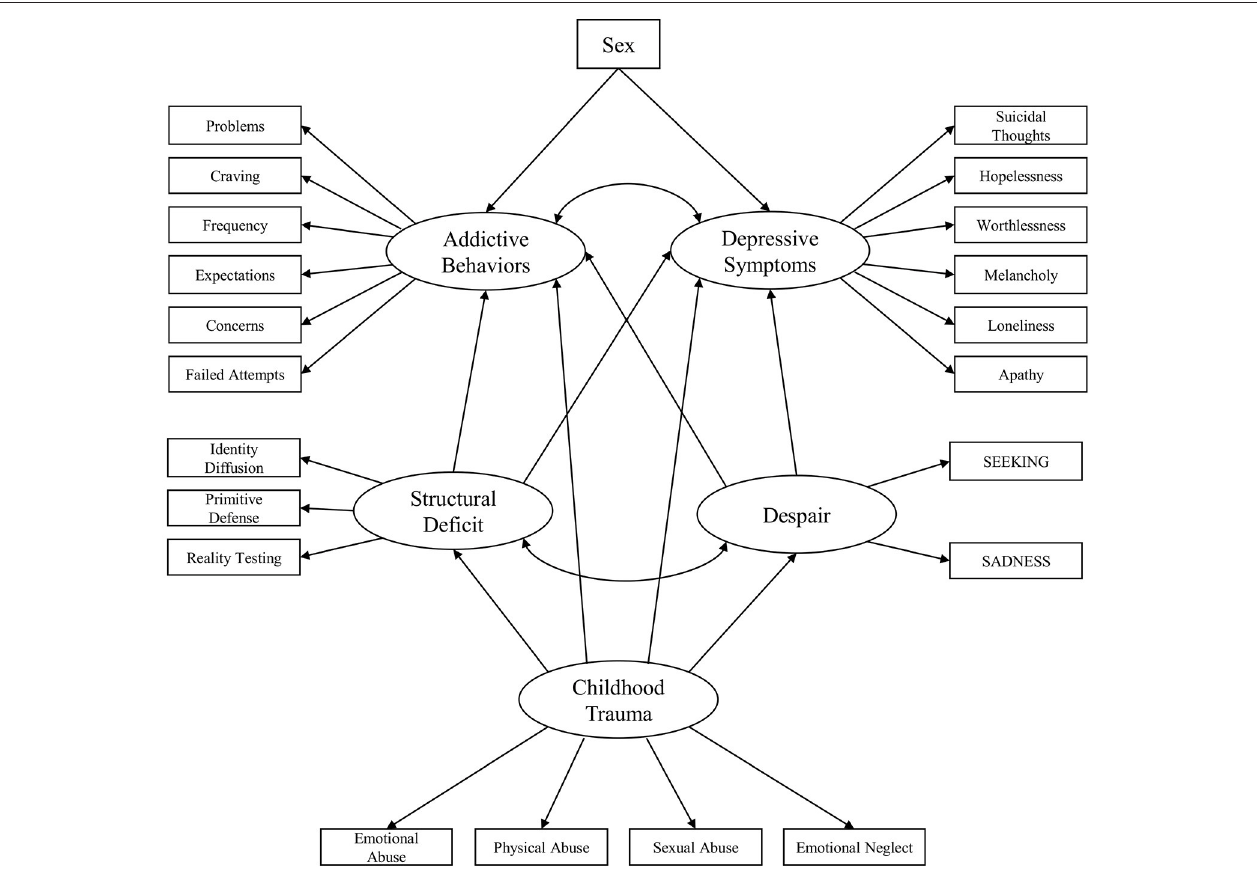
FIGURE 1 | Initial conceptualized framework for the relationship between childhood trauma, despair, personality organization, depression symptoms and addiction